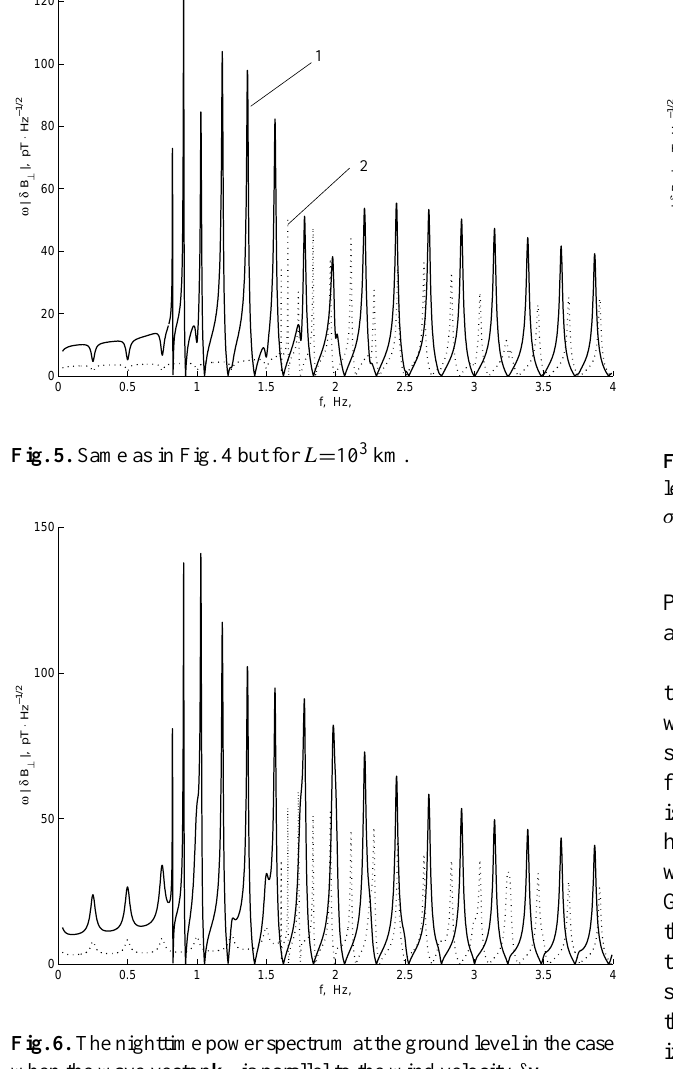
Fig. 6. The nighttime power spectrum at the ground level in the case when the wave vector k 0 is parallel to the wind velocity δ v .